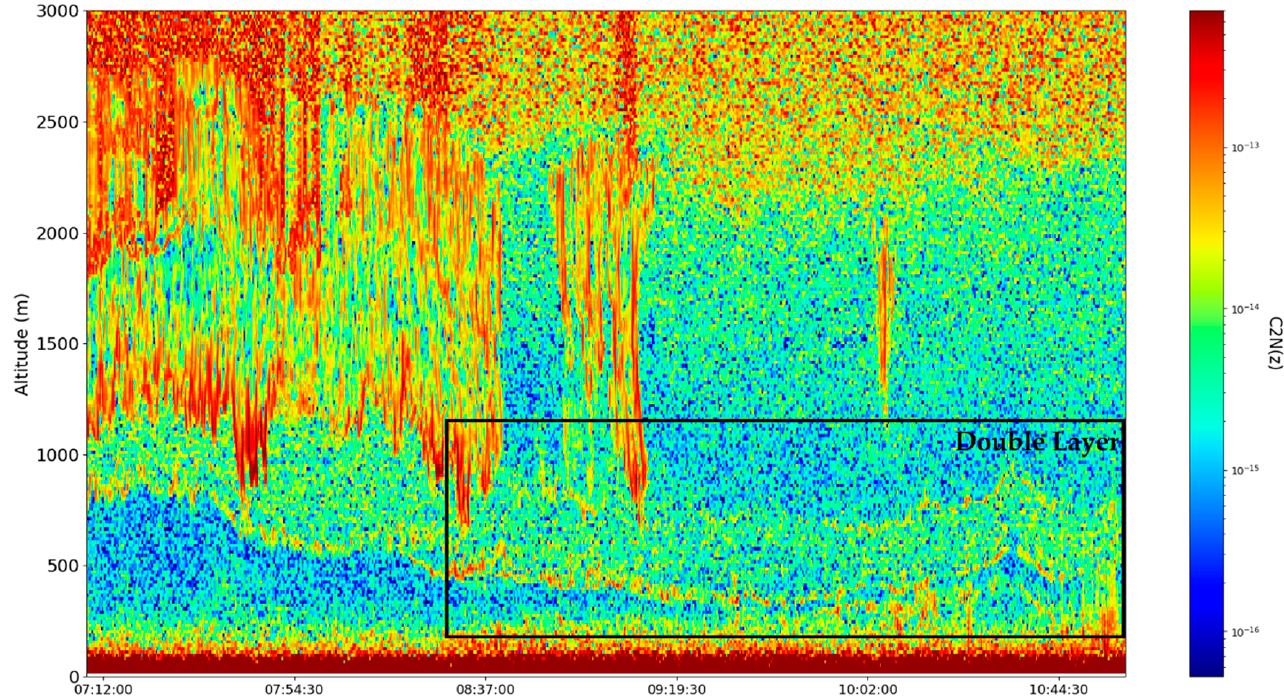
Figure 18. Zoomed-in (region of interest) C 2 time series, λ = 1064 nm , Gala ț i, Romania, 23 December 2021.